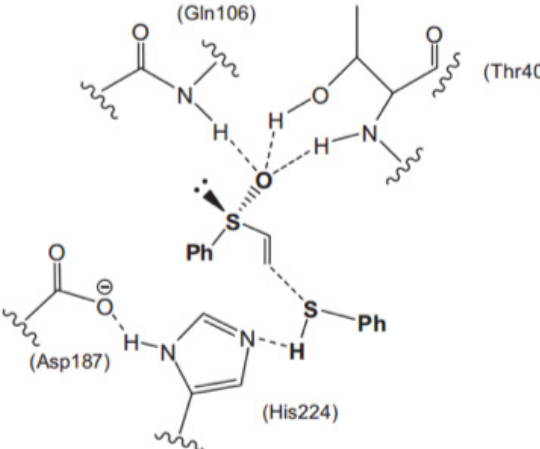
Figure 36 - Addition of nucleophiles to α,β-unsaturated sulfinyl derivatives using hydrolytic enzymes. Figure adapted with permission from Elsevier (Madalinska et al.